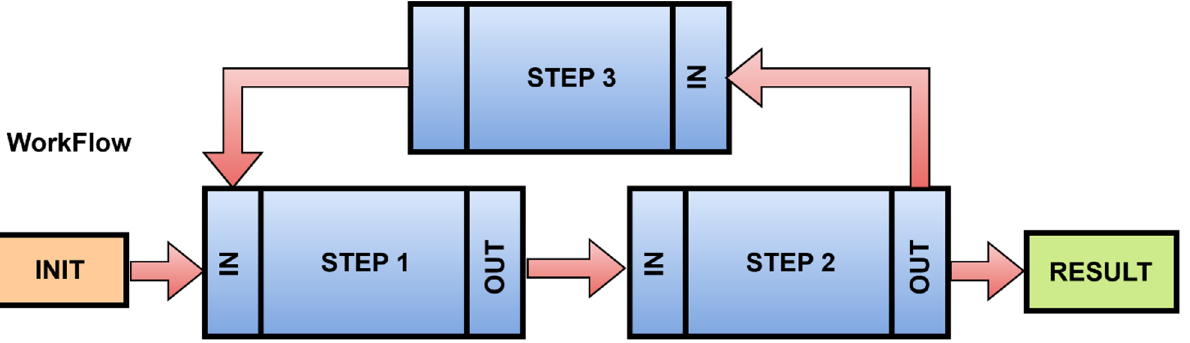
Figure 11. A scheme of drawn steps and their dependencies—workflow. Table 1. Overview of IO protocols for IIoT